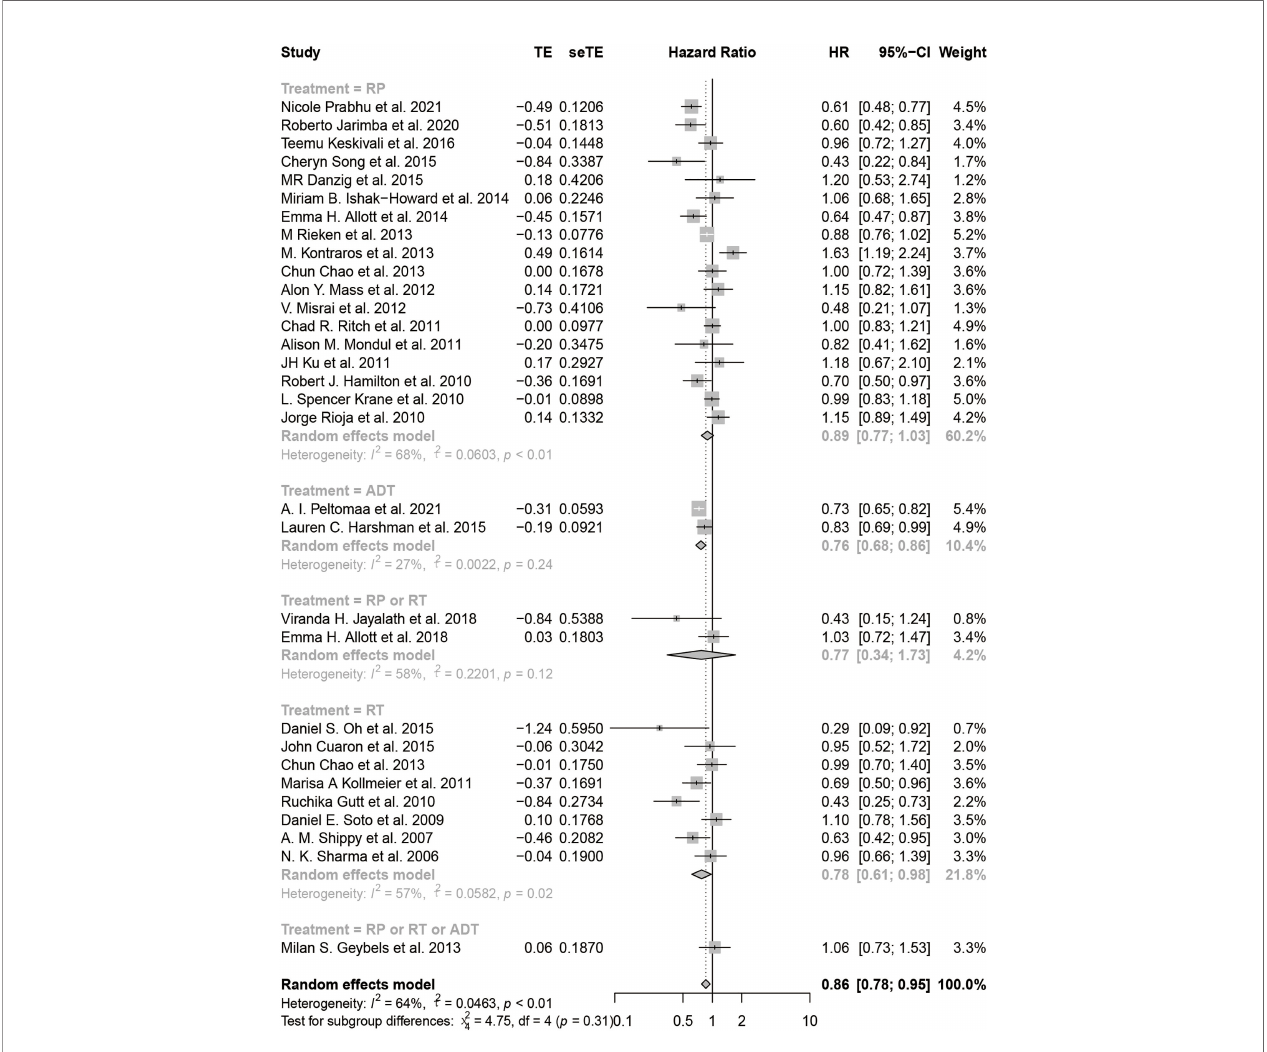
FIGURE 3 | The forest plot for the HR of BCR with subgroup analyses by primary